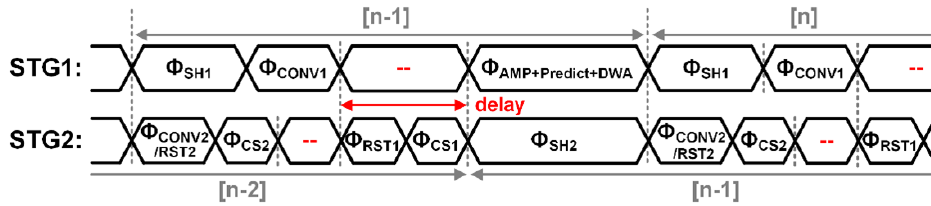
Figure 6. Inefficient ADC operation, due to delays.